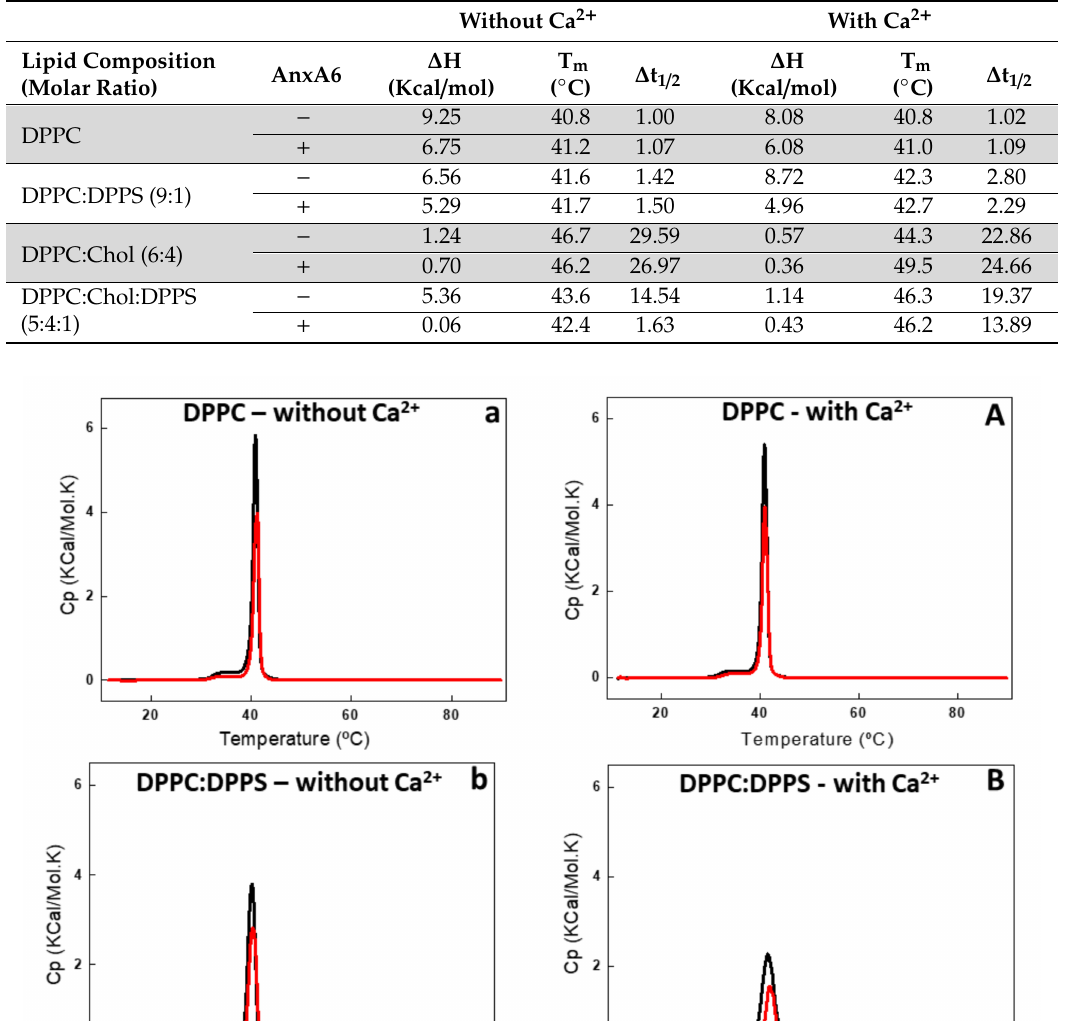
Table 2. Di ff erential scanning calorimetry (DSC)-calculated thermodynamic parameters [enthalpy ( ∆ H), transition phase temperature (T m ) and phase transition cooperativity ( ∆ t 1 / 2 )] for liposomes (10 mg / mL) and proteoliposomes with di ff erent lipid compositions, harboring or not AnxA6, and in the presence and absence of Ca 2 + (2 mM).